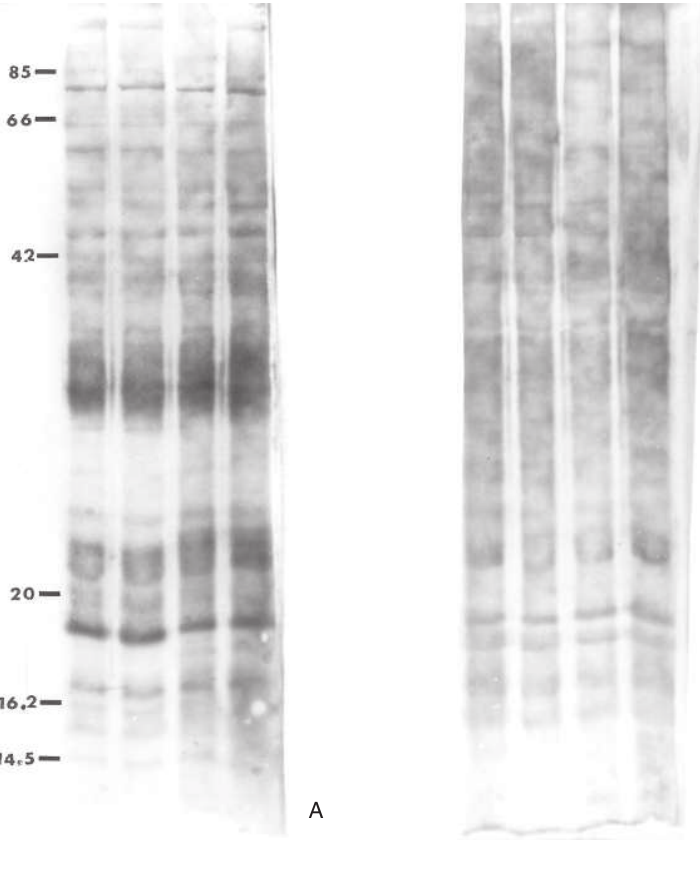
Fig. 2. – Western blot analysis with male and female somatic antigens of the sera from infected dog (A), and sera from uninfected dog